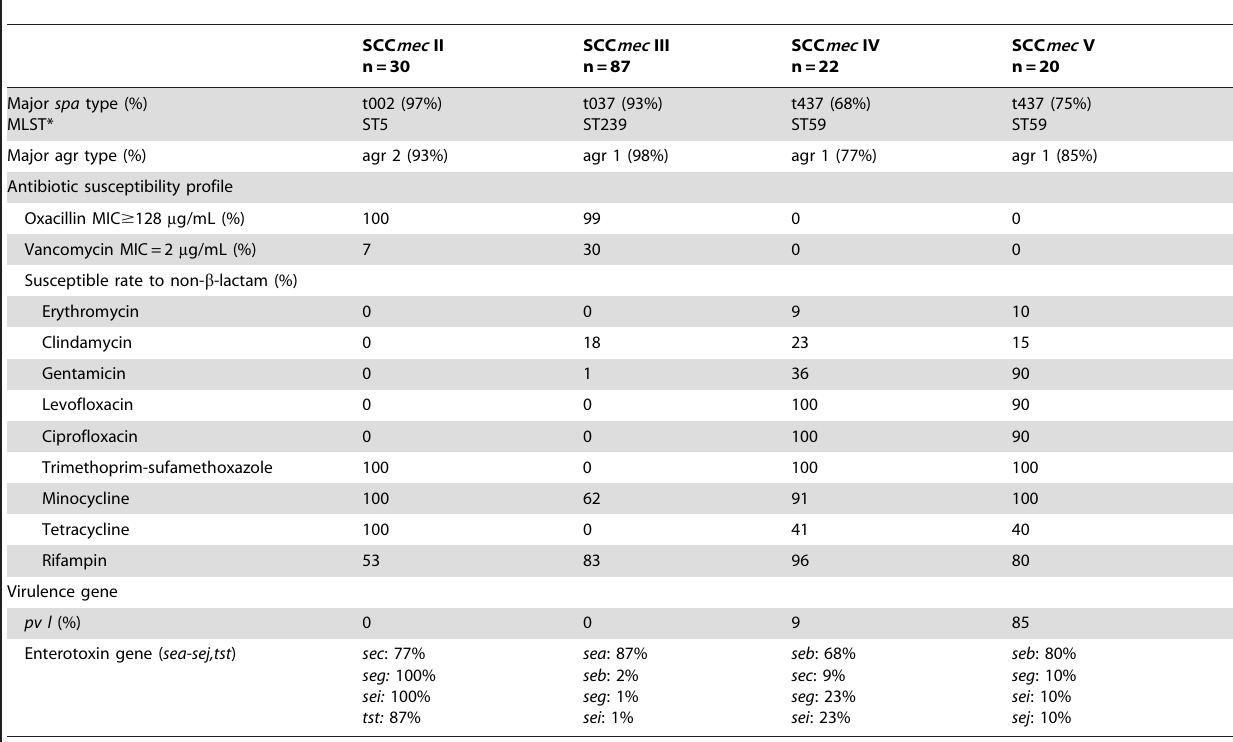
Table 4. Molecular typing, antimicrobial susceptibility, and virulence genes of MRSA isolates with different SCCmec